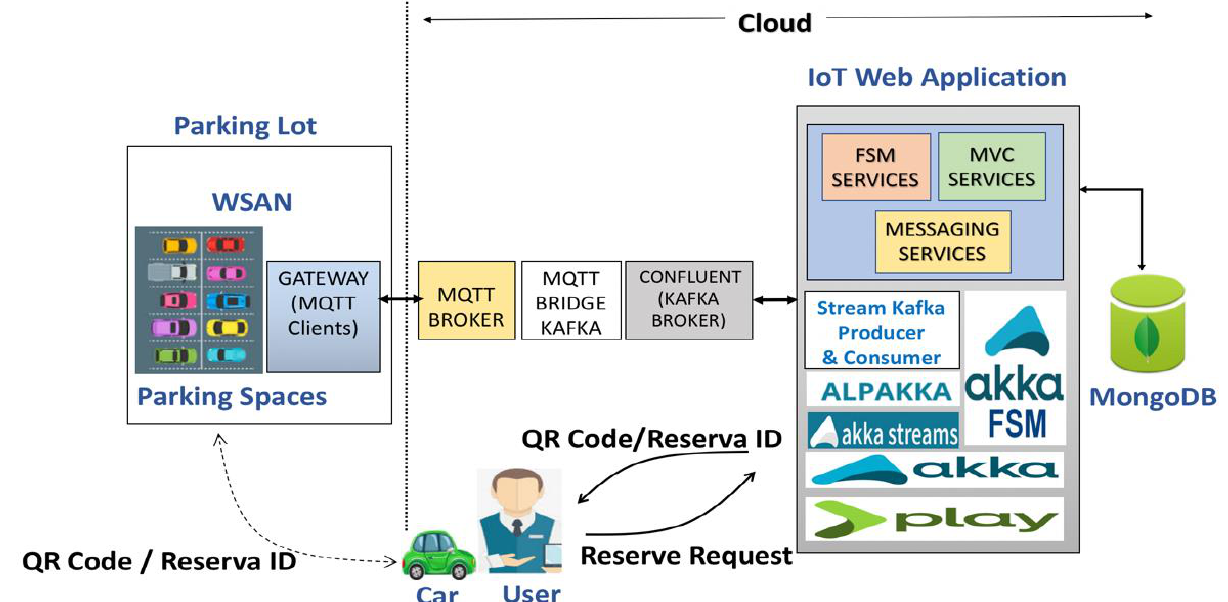
Figure 5. General model of the reactive system.